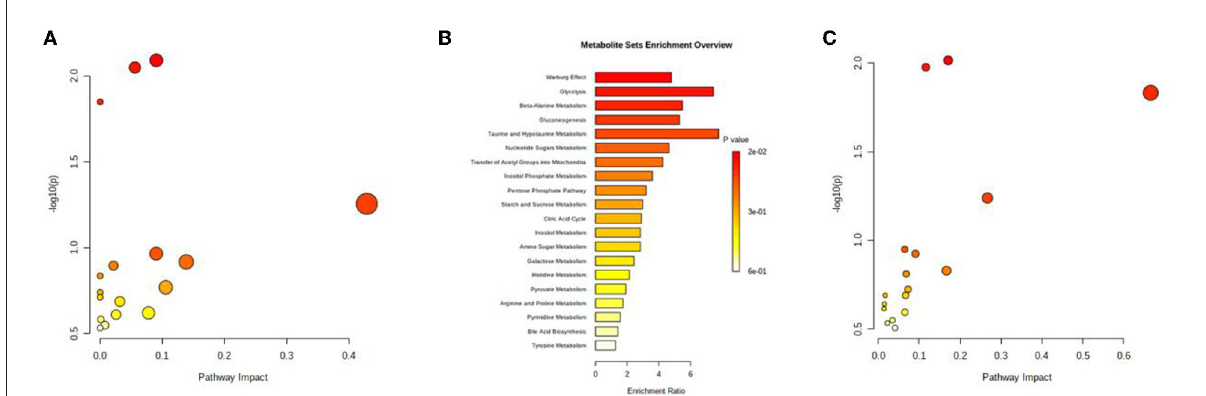
FIGURE1 Metabolomic analysis. (A) Signaling pathways associated with differentially expressed metabolites associated with high-fiber diet. (B) Bubble map of differentially expressed metabolites associated with high-fiber diet. (C) Bubble map of the interaction between differentially expressed metabolites associated with high-fiber diet and